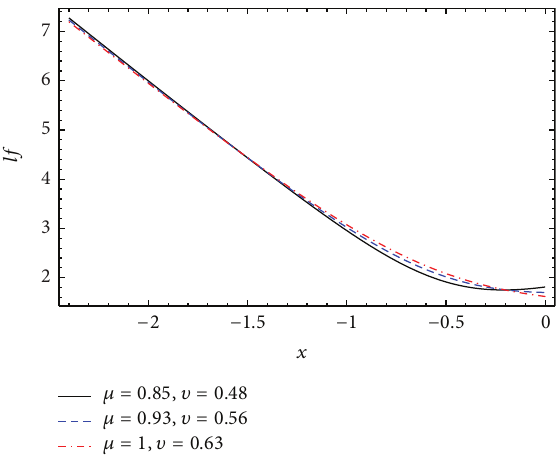
Figure 10: Reconstructed 𝑓(𝑅) for NHDE in 𝑙𝑓 − 𝑥 plane with 0 ⩽ 𝑧 ⩽ 10 , where 𝑥 = ln (1 + 𝑧) −1 .